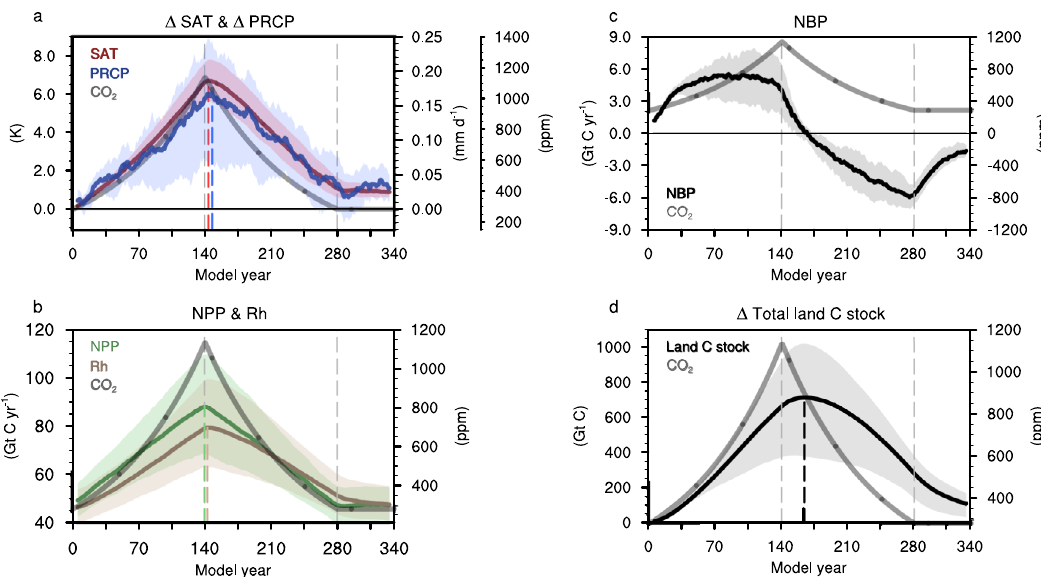
Fig. 1 Temporal evolution of global terrestrial carbon fl uxes and stock. a – d Time-series of annual mean land surface air temperature (SAT) and precipitation (PRCP) anomaly ( a ), annual net primary production (NPP) and heterotrophic respiration (Rh) ( b ), annual net biome productivity (NBP) ( c ), and annual mean total land C stock anomaly ( d ). All values are calculated over the global land area excluding Antarctica. The solid lines and shadings show the MME mean and the range of 95% con fi dence level based on the bootstrap method. All calculations were conducted after taking the 11-year running mean. The beginning and end of CO 2 changes are indicated by the gray dashed vertical line.